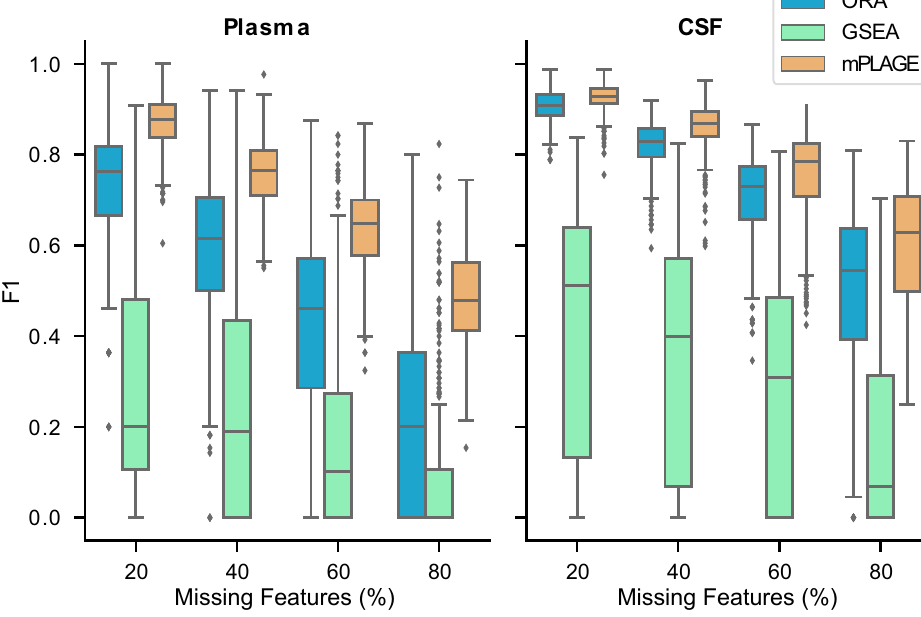
Figure 6. F 1 score results from the plasma and cerebrospinal fluid (CSF) samples from the human African trypanosomiasis (HAT) data set for varying percentages of missing features (proportion of full data set). A higher F 1 score means that the method is able to recover more of the original set of significant pathways correctly, even in the presence of missing features. The results show that mPLAGE performs better than the alternatives on real